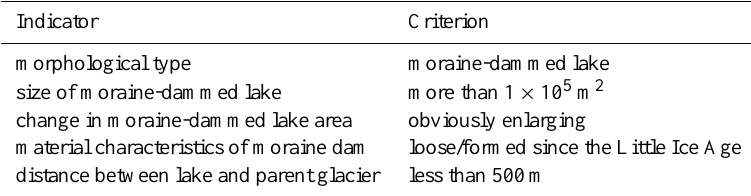
Table 1. Selected indicators of PDMDLs.